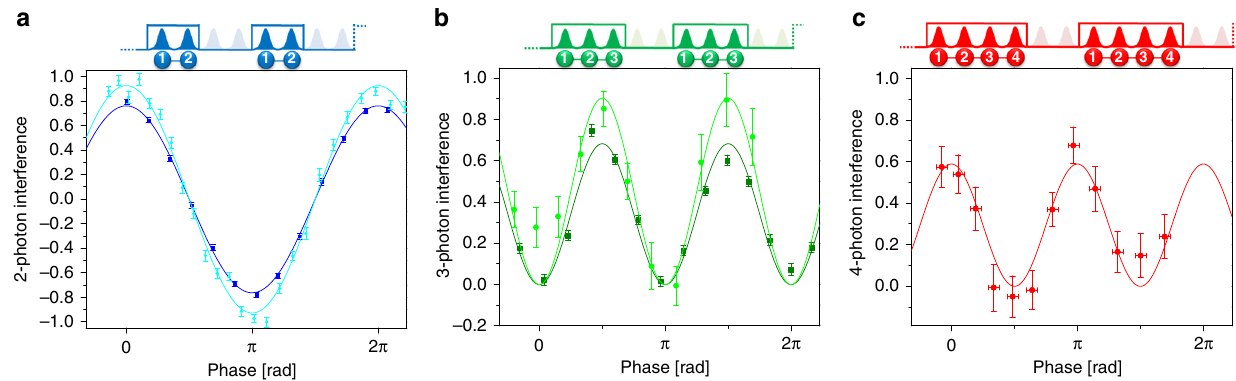
Fig. 3 Quantum interference of two, three, and four photon cluster states. The corresponding EOM pulse sequences are depicted above the graphs. a Phase scan of V 2 for a two-photon state with a fi tted maximum of 0.76 ± 0.01 at 480 Hz, 30 s per data point (dark blue), and 0.93 ± 0.02 at 50 Hz, 6 s per data point (light blue). b Phase scan of V 3 for a three-photon state with a fi tted maximum of 0.68 ± 0.03 at 4.3 Hz, 11 min per data point (dark green), and 0.90 ± 0.07 at 0.33 Hz, 8 min per data point (light green). c Phase scan of V 4 0 for a four-photon state with a fi tted maximum of 0.59 ± 0.04 at 0.04 Hz, 50 min per data point. Error bars are calculated assuming Poisson distribution. Phase error bars for c are calculated from two-photon residuals fi t for multiple scans. Background counts from residual un fi ltered pump and detector after-pulsing events are subtracted (see Supplementary Note 7).